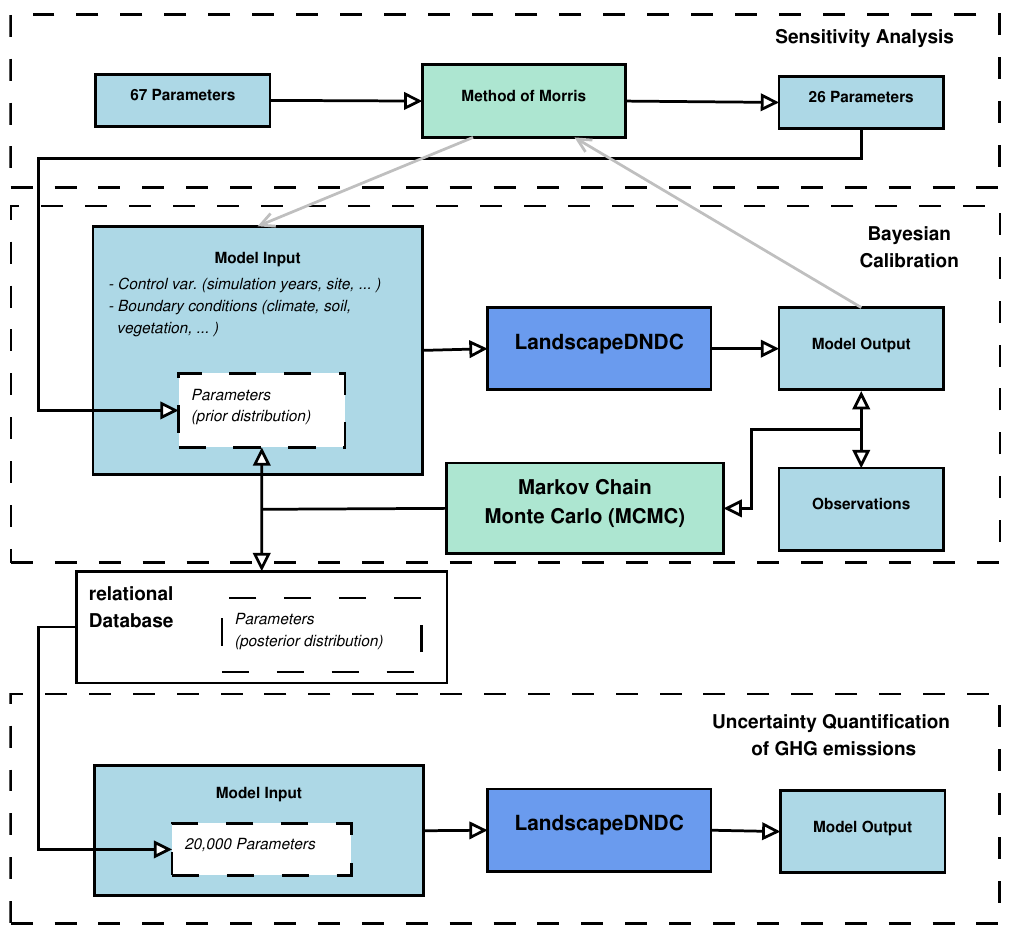
Fig. 1. Schematic view of the workflow for assessing the uncertainty of simulated soil GHG emissions while using LandscapeDNDC. After reduction to influential parameters by means of a sensitivity analysis, the distribution of the model parameters was estimated using a Bayesian calibration. Subsequently, an uncertainty quantification of simulated emissions was carried out using 20000 samples out of the 533000 post burn-in realisations of the parameter distribution stored in a relational